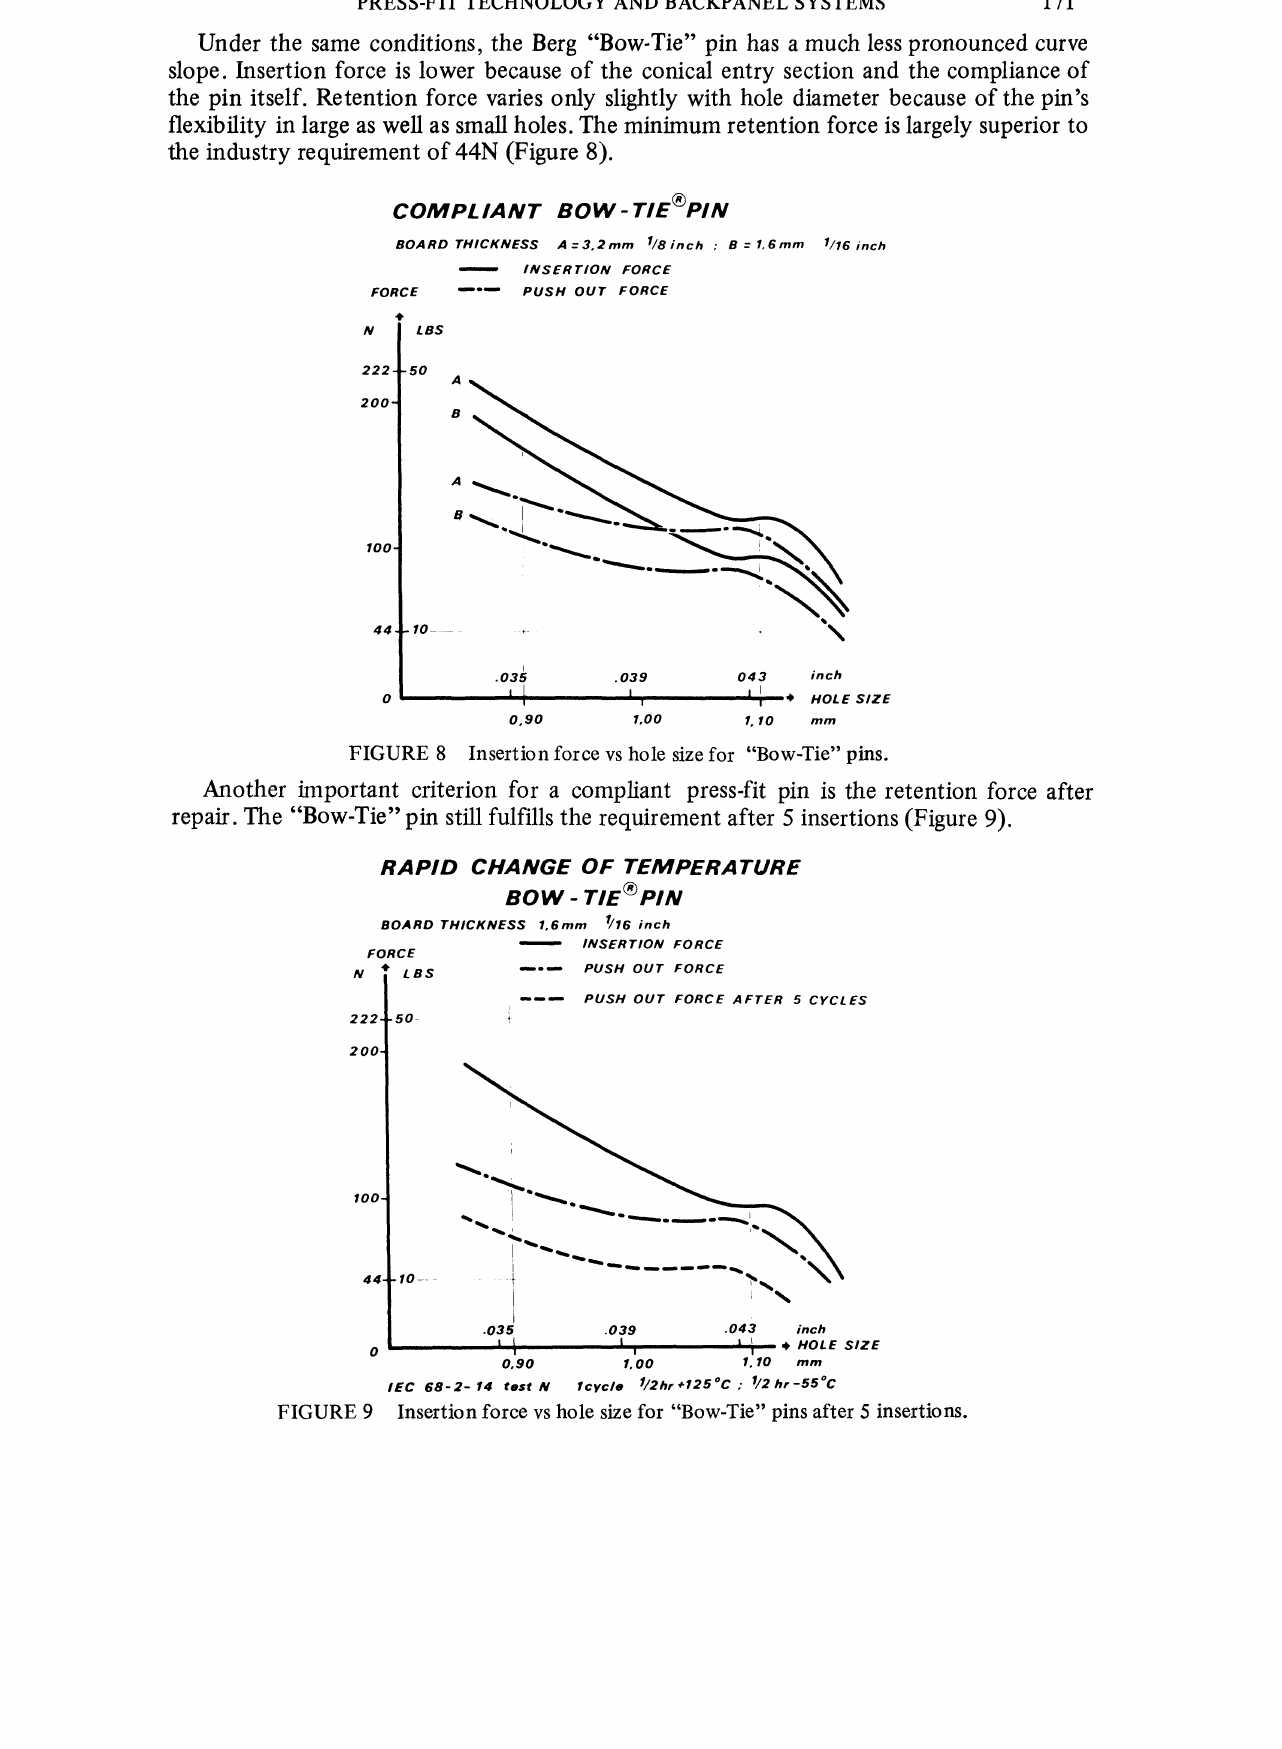
FIGURE 9 Insertion force vs hole size for "Bow-Tie" pins after 5